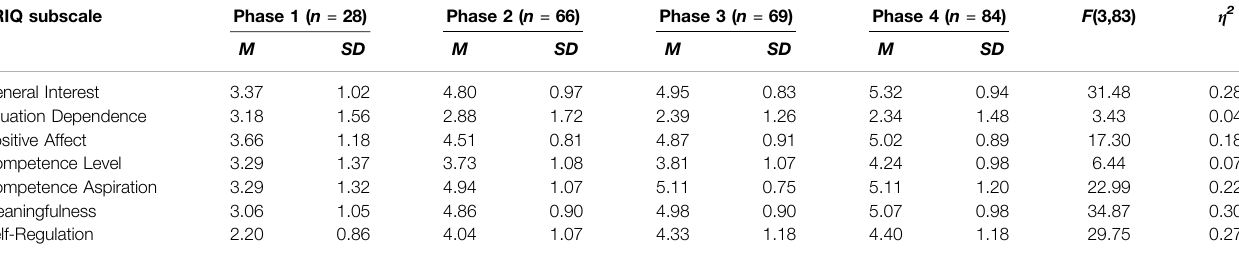
TABLE 1 | Means, standard deviations, and multiple analysis of variance between-group effects for TRIQ object-general (X) subscales by interest phase. TRIQ subscale